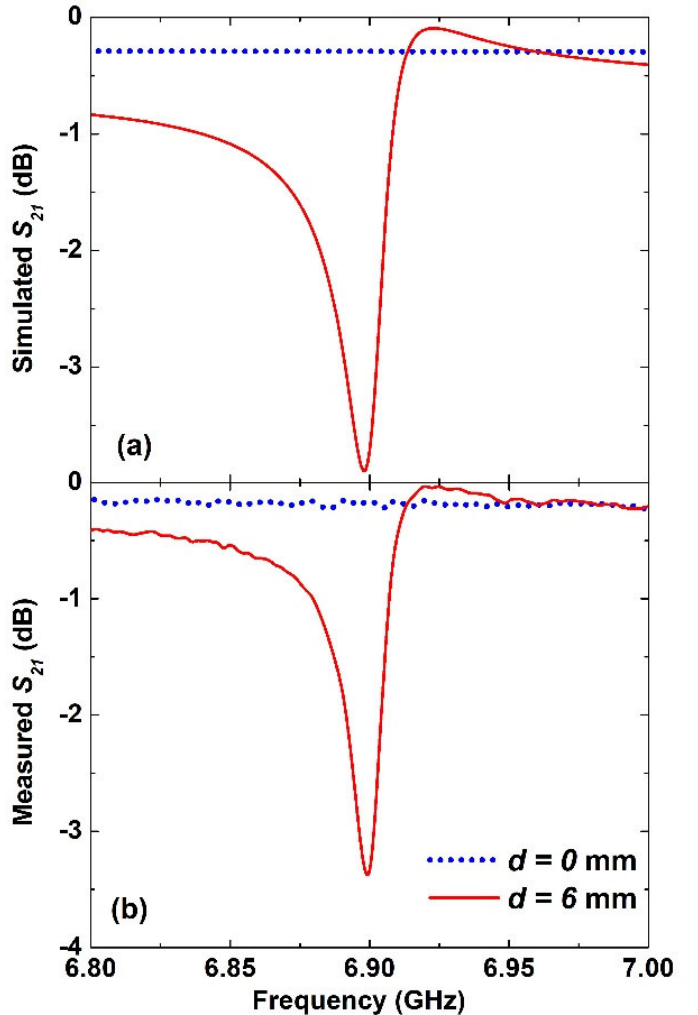
Figure 2. ( a ) Simulated and ( b ) measured normalized transmission amplitude coefficient ( S 21 ) for the symmetric configuration at d = 0 (dotted blue lines) and the asymmetric configuration with d = 6 mm (solid red lines).